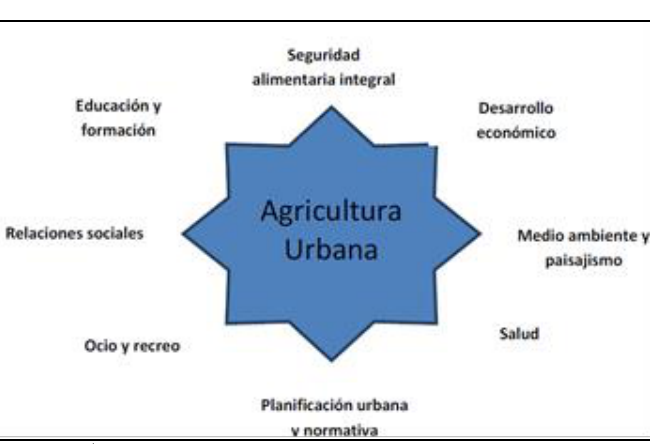
Figura1: Áreas de gobernanza en la Agricultura Urbana . Fuente: Los autores, (2018). Seguridad alimentaria